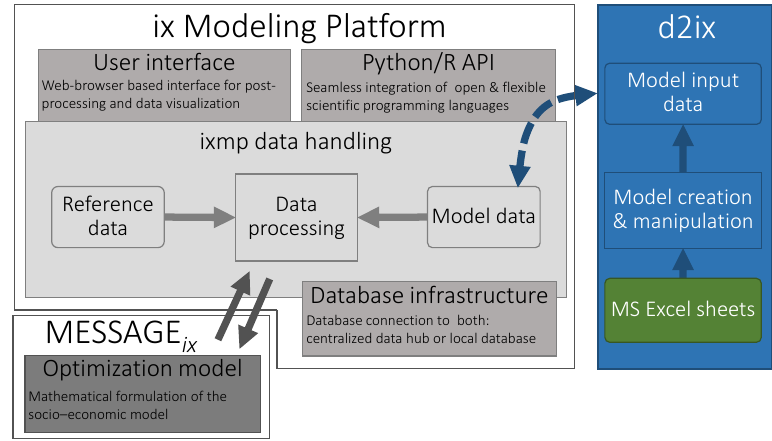
Figure 2. Integration and interlinkages of d2ix to the ixmp modelling-platform (adapted from